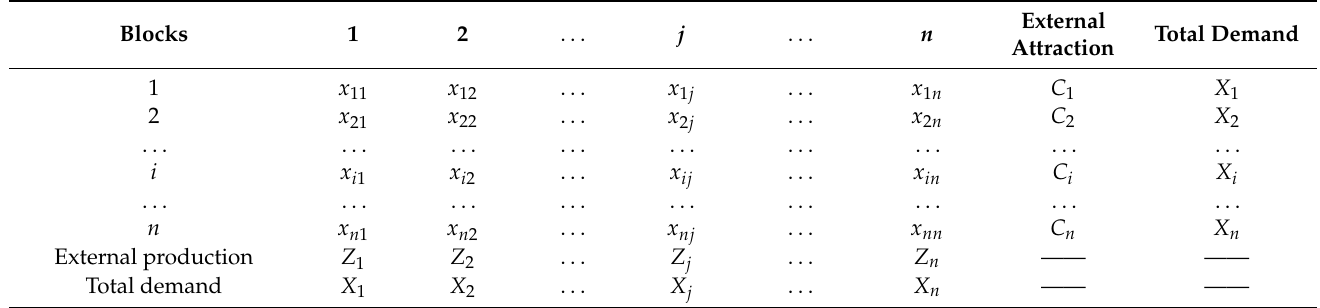
Table 1. Taxi travel demand table between different types of